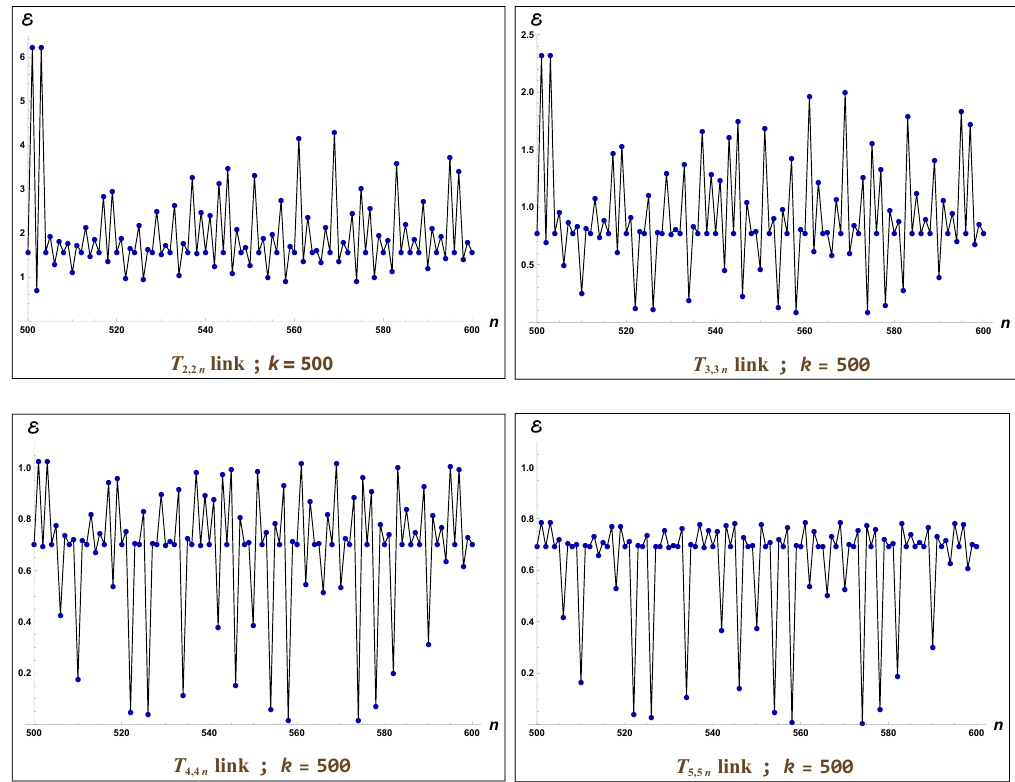
Figure 12. The variation of the entanglement entropy with n for large values of k and n